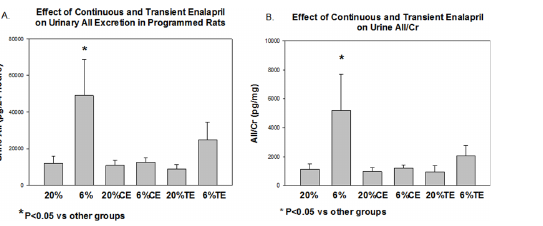
Fig 3. Effect of continuous and transient enalapril on urine angiotensin II levels in control and programmed rats. Rats from the 6 groups were placed in metabolic cages at 6 months of age. 24 hour total urine angiotensin II (A) and urinary angiotensin II/creatinine (Cr) levels (B) were measured in control and prenatal programmed rats. Urine angiotensin II/24 hours and urinary angiotensin II/Cr were higher in the offspring of the 6% rats compared to all other groups. N = 11 – 16 in each